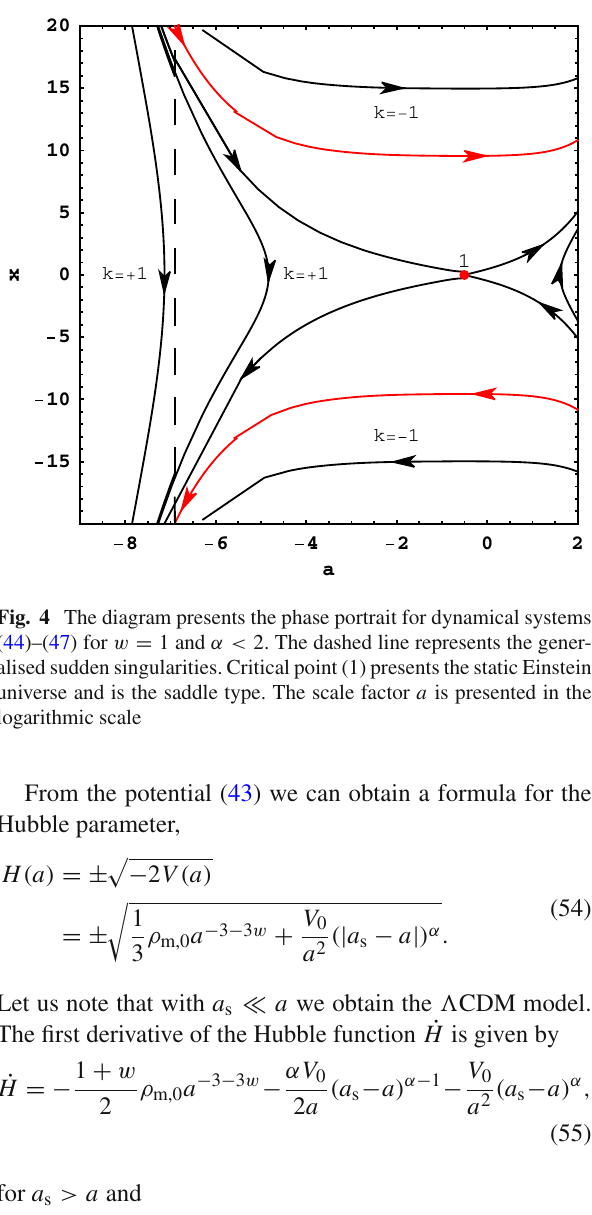
Fig. 3 Thediagrampresentsthepotentialfunction V ( a ) (43)for α < 0 (big freeze). The dashed line represents the big freeze singularities